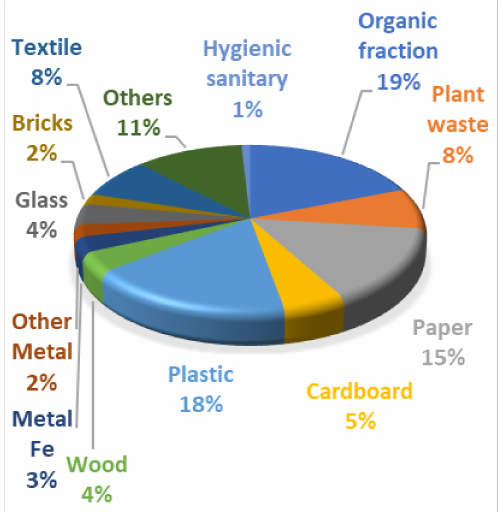
Figure 2. Average composition of the